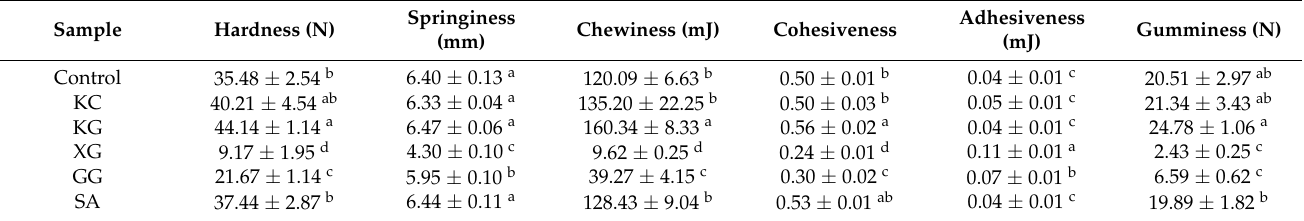
Table 2. Texture profile analysis (TPA) indicators for 3D-printed cylindrical surimi after cooking.